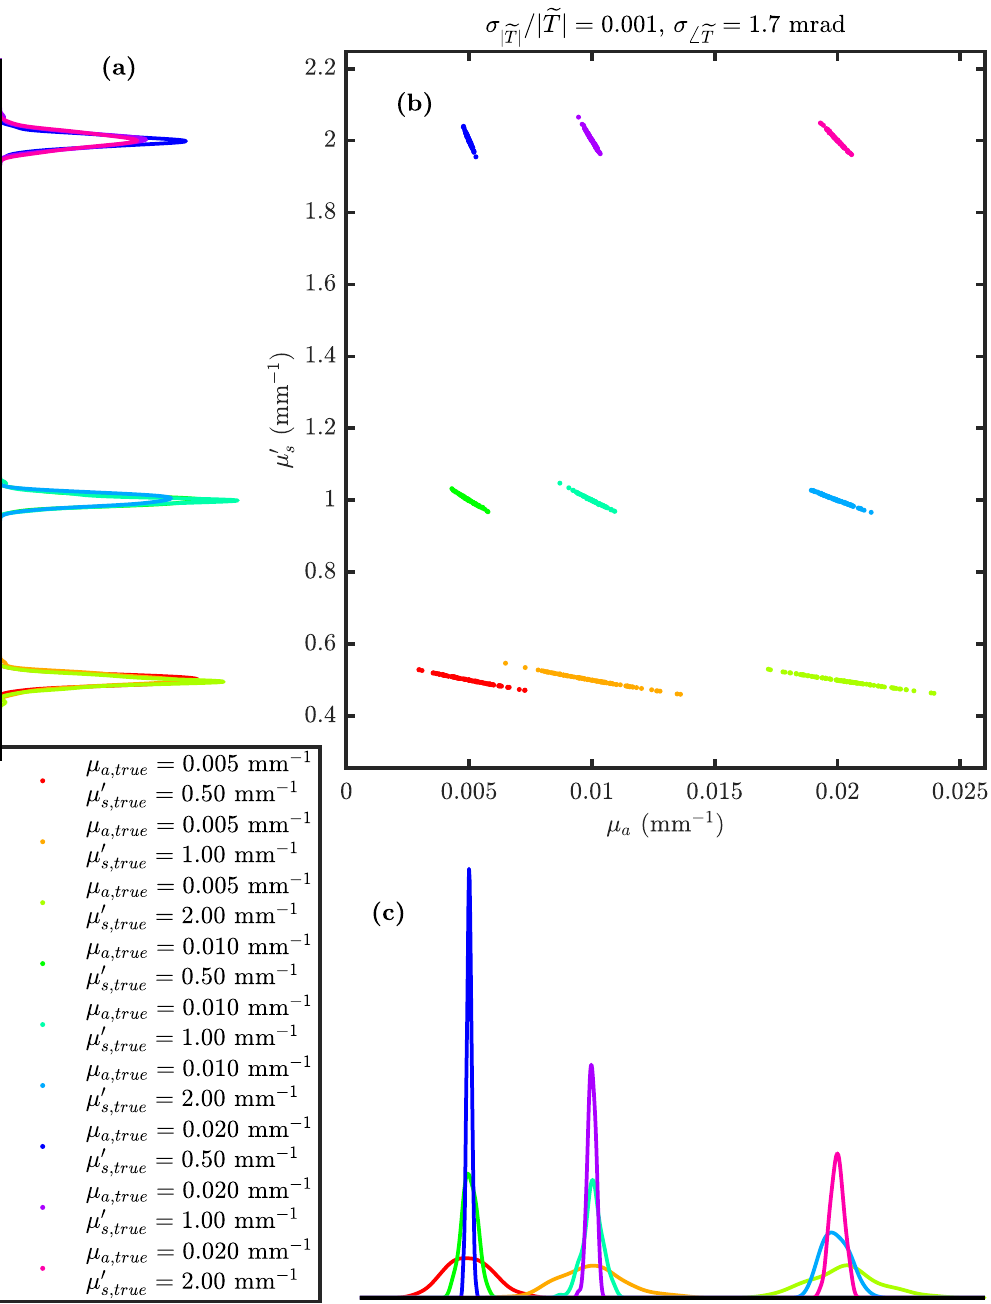
= 1.7mrad = 0.1°) for the Figure 8. Result from 101 simulations of noise ( σ / | (cid:101) T | = 0.01 and σ ∠ | (cid:101) T | (cid:101) T 9 different true sets of the µ a and the µ (cid:48) s shown in Figure 6. ( a ) Marginal histograms for recovered µ (cid:48) s values of the 9 sets of optical properties and 101 noise simulations. ( b ) Scatter plot of recovered µ a and µ (cid:48) s for the 9 × 101 noise simulations. ( c ) Marginal histograms for recovered µ a values of the 9 sets of optical properties and 101 noise simulations. Acronyms and Symbols: Green’s function for the complex Transmittance ( (cid:101) T ), uncertainty ( σ ), absorption coefficient ( µ a ), and reduced scattering coefficient ( µ (cid:48) s